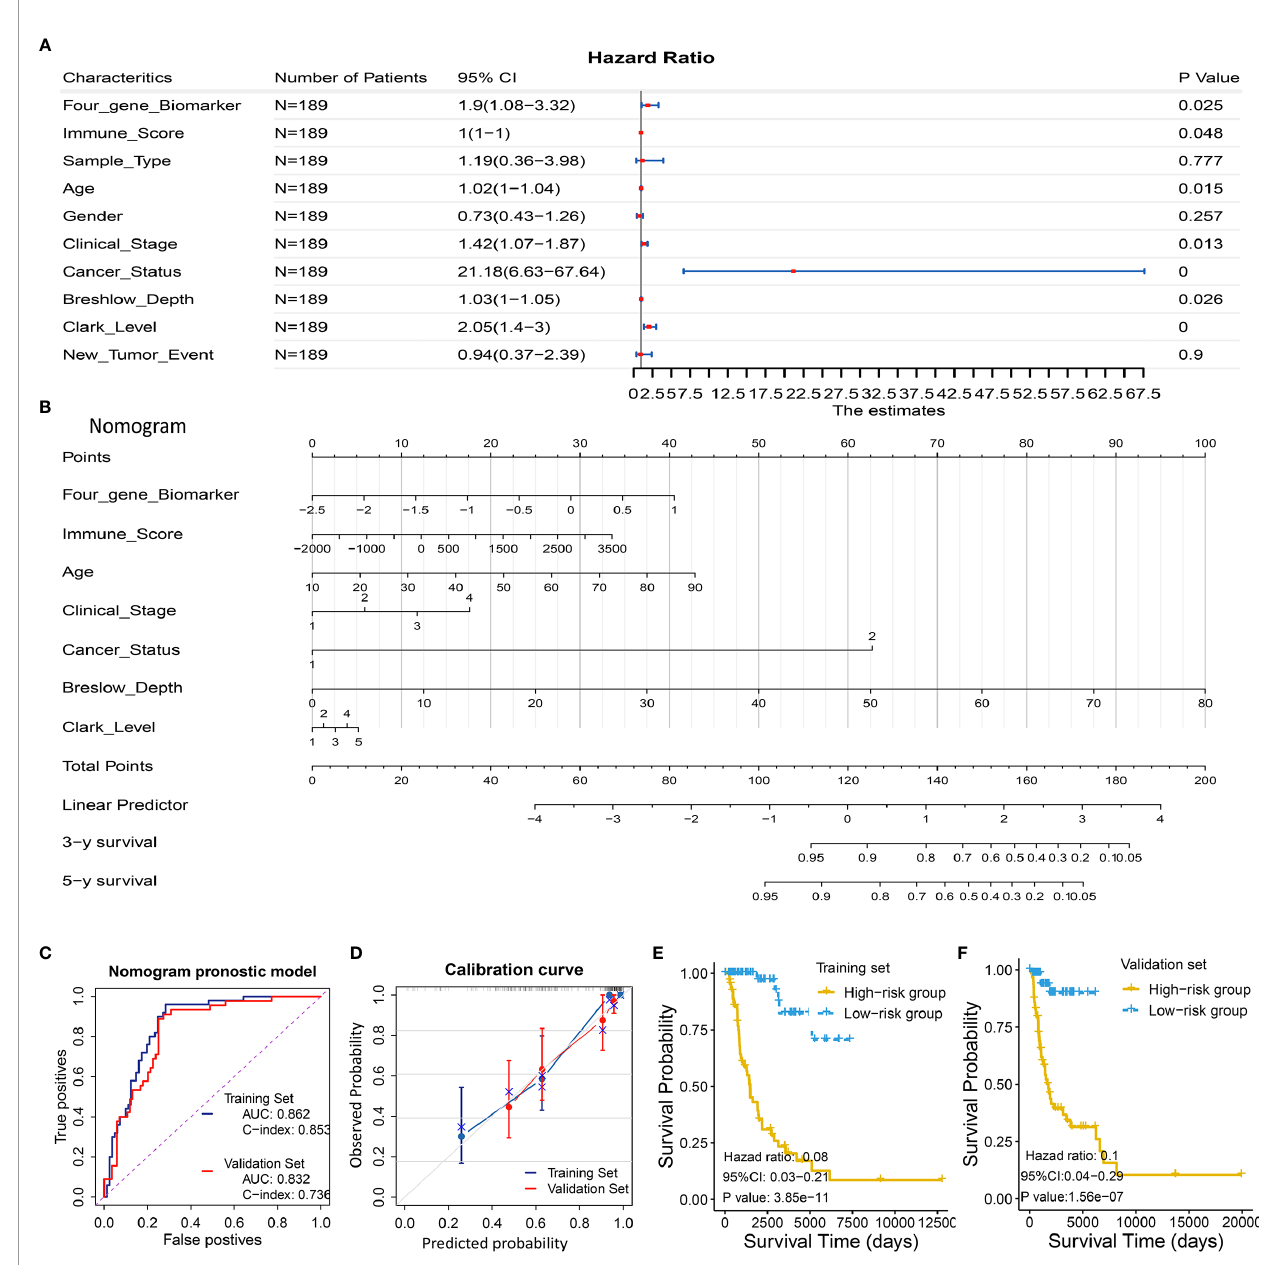
FIGURE 5 | Development and validation of a predictive nomogram for predicting survival probability. (A, B) Development of a predictive nomogram combing the four-gene biomarker and clinical factors in melanoma based on the training set II. (A) Univariate Cox regression were used to screen for clinical factors that were signi fi cantly correlated with overall survival in the training set II (n = 189), as shown in the forest plot. Seven factors including the four-gene biomarker were signi fi cantly associated with overall survival. (B) A nomogram combing the four-gene biomarker and clinical factors for predicting 3- and 5-year overall survival for melanoma patients. Cancer status represents personal cancer status (with tumor/tumor-free), which is one of the clinical characteristics for melanoma patients. (C – F) Four criteria were utilized to assess the predictive performance in the training set II and validation set II. (C) AUC and C-index were calculated for the nomogram prognostic models in the training set (n = 189) and validation set (n = 190). AUC of the nomogram was 0.862 ± 0.062 and 0.832 ± 0.071, and C-index was 0.853 ± 0.024 and 0.736 ± 0.041, in the training group and validation group, respectively. (D) Calibration curves of nomograms in training set and validation set. X-axis represents predicted probability and Y-axis represents true probability. Each point in the plot represents a subgroup of patients. Error bars represent 95% con fi dence intervals. 45° represents perfect prediction, and the actual performances of our nomogram are very well. (E, F) The resulting nomogram prognostic model was utilized to calculate risk score of cases in the training set and validation set. Low risk score subgroup had a signi fi cantly improved survival compared to high risk score (grouped according to median risk score value), in training set and validation set. The fi ndings support the predictive power of the proposed